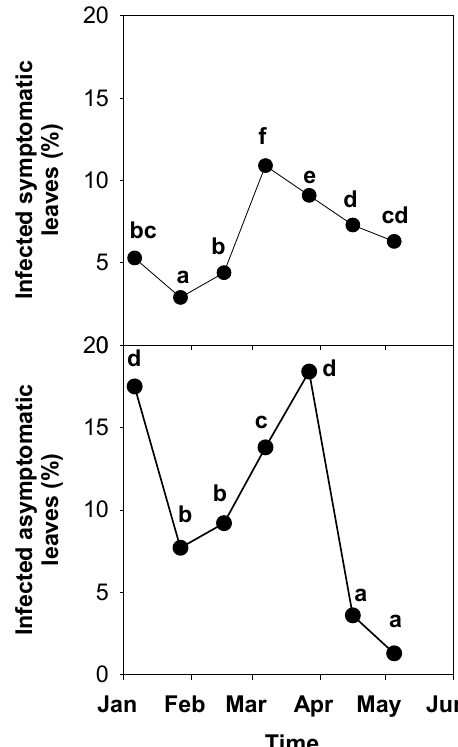
Figure 2. Mean proportions of olive leaf infections by Venturia olea- ginea as influenced by the time of observation. Means accompanied by the same letter are not significantly different ( P ≤